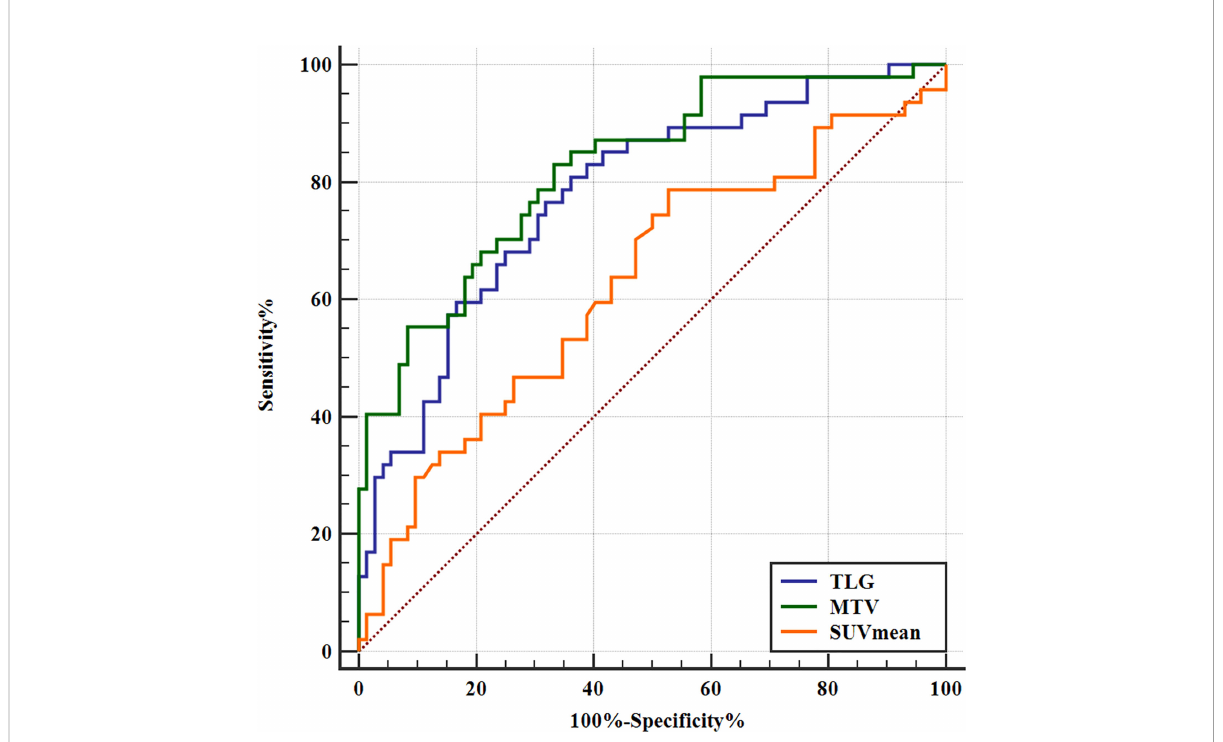
FIGURE 2 Receiver operating characteristic (ROC) curves of SUVmean, MTV, and TLG for predicting binary stage of SCLC. The SUVmean, MTV, and TLG could predict tumor stage. The ROC curve analysis of the SUVmean to predict ED-SCLC. With an SUVmean of 7.69 as the threshold, the sensitivity and speci fi city in the prediction of ED-SCLC were 78.72% and 47.22%, respectively. The AUC was 0.628 (95% CI: 0.535 – 0.715; p = 0.0166). The ROC curve analysis of the MTV to predict ED-SCLC. With an MTV of 61.36 as the threshold, the sensitivity and speci fi city in the prediction of ED-SCLC were 82.98% and 66.67%, respectively. The AUC was 0.823 (95% CI: 0.742 – 0.887; p < 0.0001). The ROC curve analysis of the TLG to predict ED-SCLC. With a TLG of 405.85 as the threshold, the sensitivity and speci fi city for the prediction of ED-SCLC were 80.85% and 63.89%, respectively. The AUC was 0.779 (95% CI: 0.694 – 0.850; p <